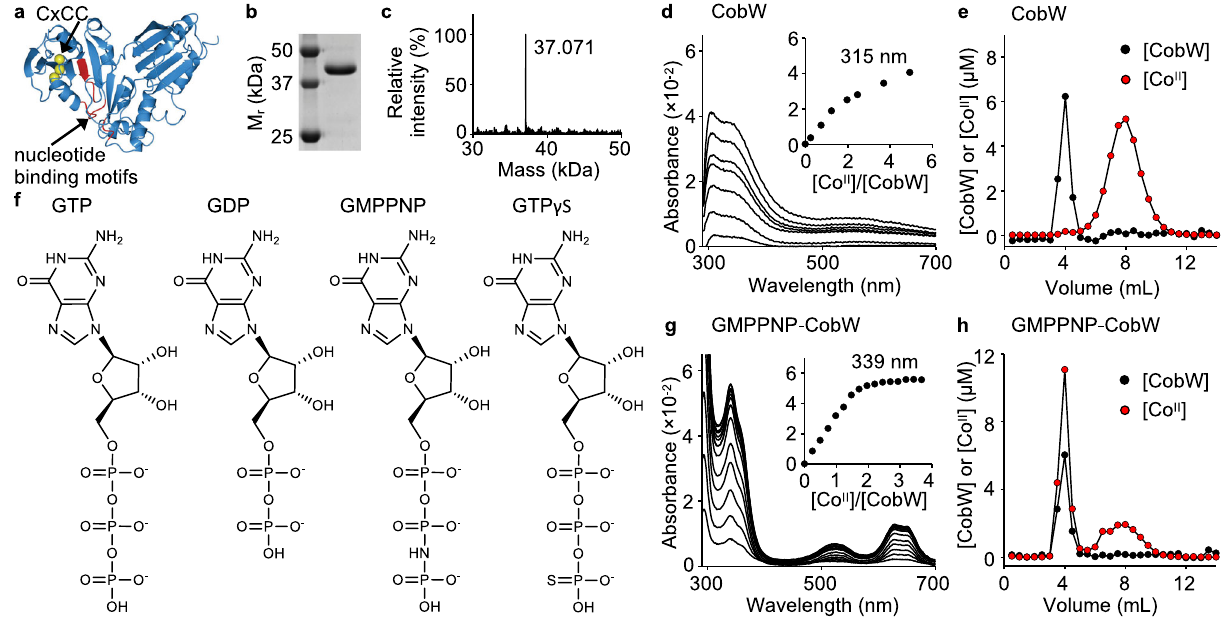
Fig. 1 Co II binding to CobW is enhanced by guanine nucleotides. a Homology model of CobW (generated with SWISS-MODEL 67 using E. coli YjiA PDB entry 1NIJ 68 as template; image generated using CCP4 Molecular Graphics software) showing sulfur atoms from conserved CxCC motif (in yellow) and nucleotide-binding (GxxGxGKT, hhhExxG, SKxD*) motifs 15,16 (in red). *Ordinarily NKxD but [ST]KxD observed in some COG0523 proteins 15 . b Puri fi ed CobW analysed by SDS-PAGE (full image in Supplementary Fig. 1; n = 1 under these conditions). c ESI-MS analysis (de-convoluted spectra) of puri fi ed CobW. d Representative ( n = 2) apo-subtracted spectra of Co II -titrated CobW (26.1 µ M); feature at 315 nm (inset) shows a non-linear increase. e Representative ( n = 2) elution pro fi le following gel- fi ltration of a mixture of CobW (10 µ M) and Co II (30 µ M) showing no co-migration of metal (red) with protein (black). Fractions were analysed for protein by Bradford assay and for metal by ICP-MS. f Structures of nucleotides used in this work (generated using ChemDraw software). g As in d for a mixture of CobW (24 µ M) and GMPPNP (60 µ M); feature at 339 nm (inset) showing a linear increase saturating at 2:1 ratio Co II :CobW ( n = 2). h As in e for a mixture of CobW (10 µ M), Co II (30 µ M) and GMPPNP (30 µ M) showing co-migration of 1.8 equivalents Co II per CobW (mean value from peak integration, n = 2 independent experiments). Data replicates are shown in Supplementary Fig.